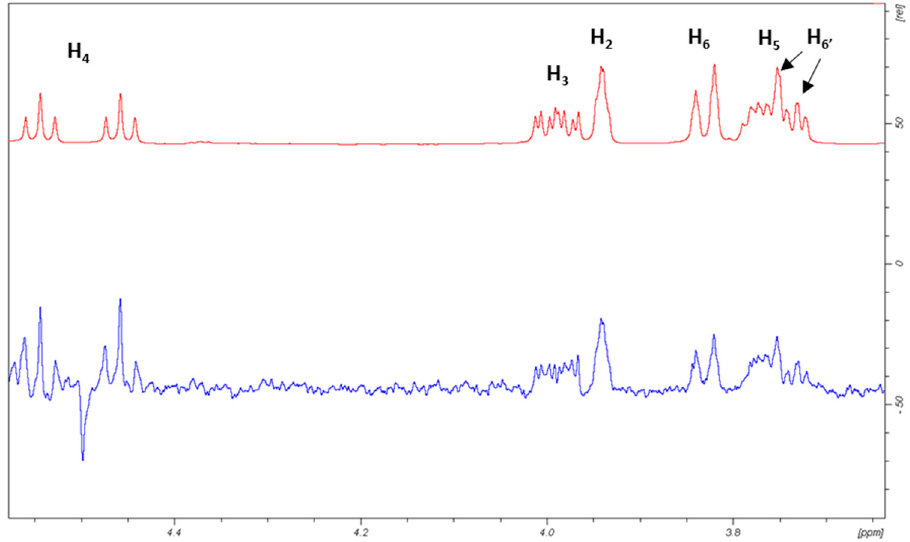
Figure 8. Expansion of the sugar region of the STD-NMR spectrum obtained for α -OMe-4-F-Man (5 mM) in the presence of DC-SIGN (65 μ M, ligand/lectin ratio is 77/1). Top: Off-resonance spectrum. Bottom: STD spectrum. H-4 shows the largest STD signal. The spectra were obtained for 1024 scans at 298 K with off-resonance irradiation at 60 ppm. In this particular case, protein irradiation was set at 0.81 ppm with a saturation time of 2 s. Additional experiments were carried out irradiating at the aromatic region and employing different saturation times (0.5, 1.0, and 3.5 s). No STD was obviously observed in the absence of DC-SIGN.